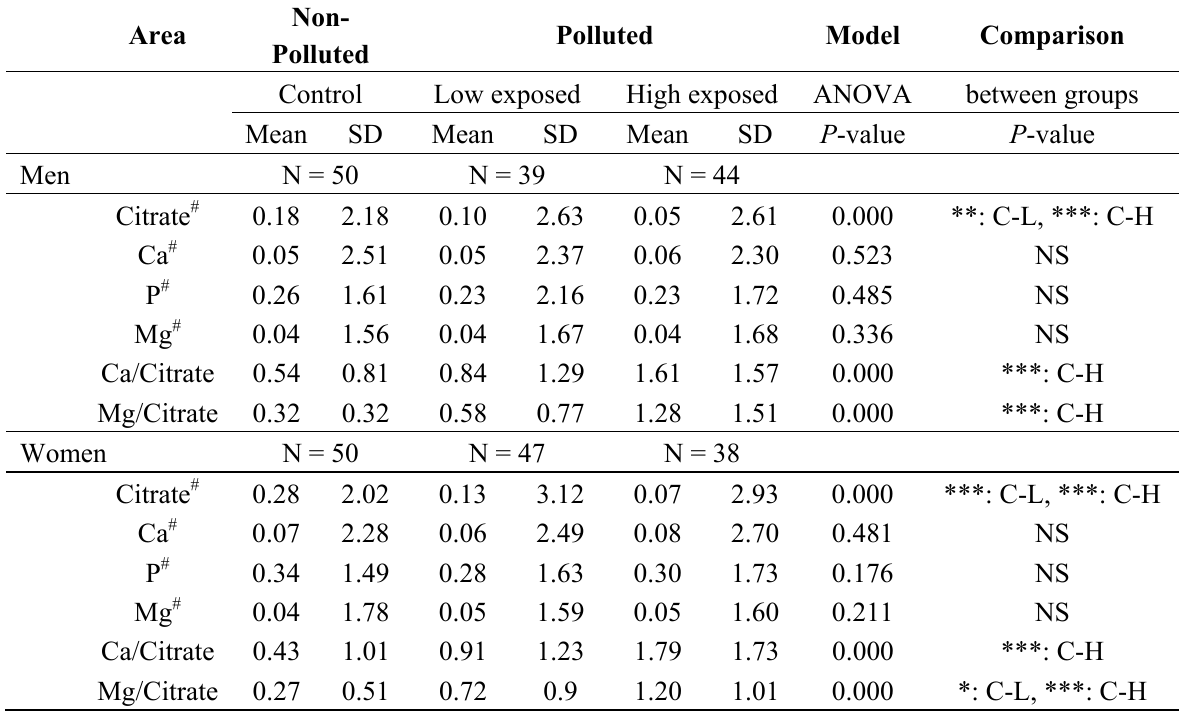
Table 3. Comparisons of citrate, calcium and magnesium in urine among subjects with different exposure levels, as analyzed by one-way ANOVA. Non- Polluted Model Comparison Area Polluted Control Low exposed High exposed ANOVA between